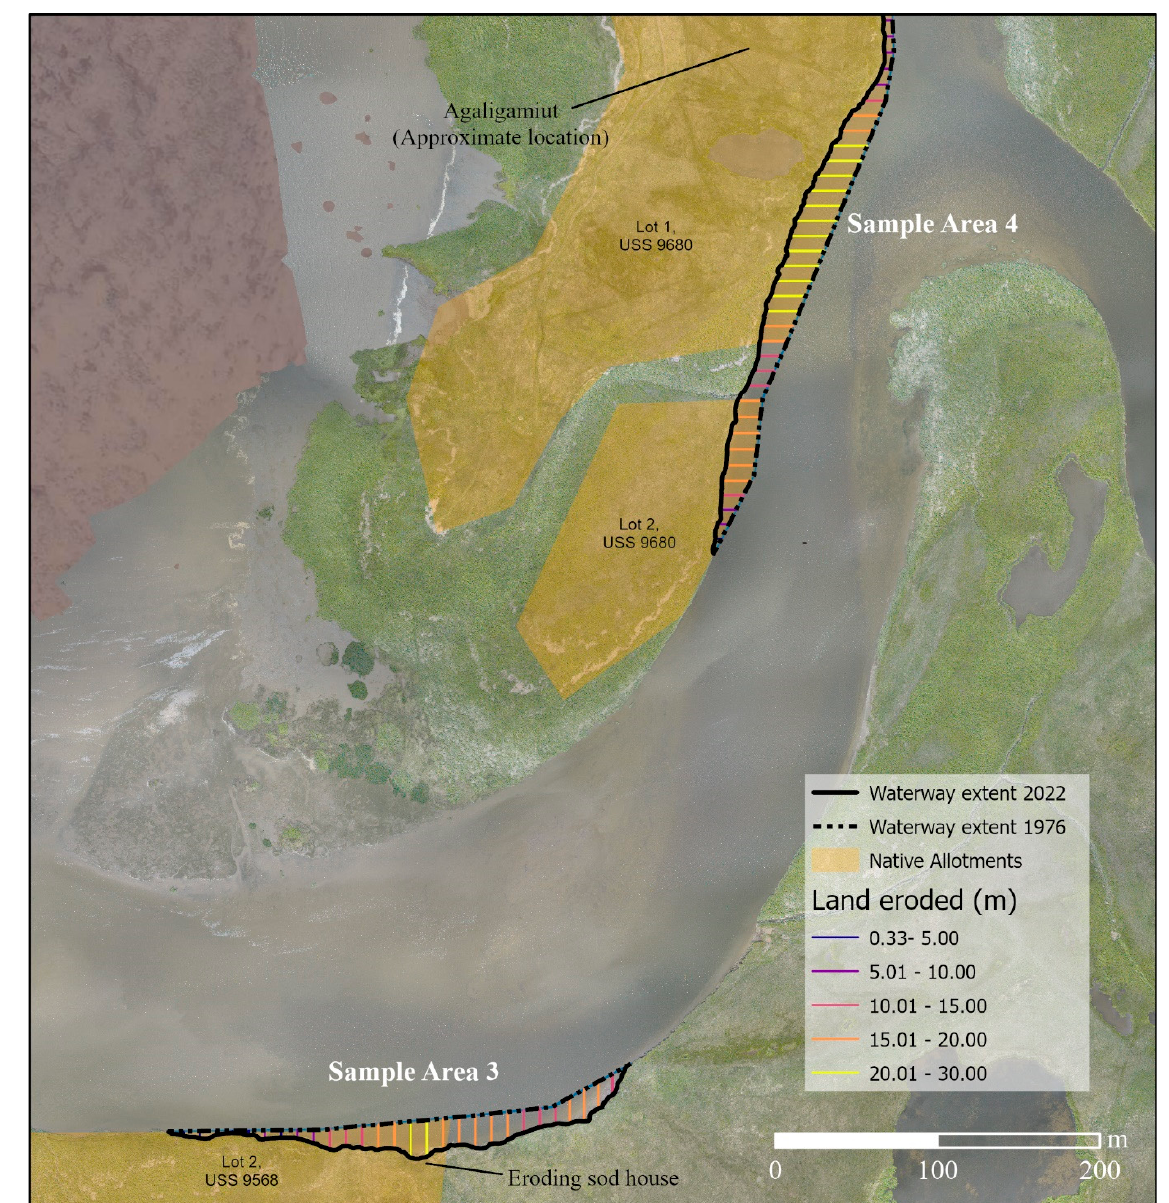
Figure 5. Erosion at the mouth of the Agalig. Aerial orthomosaic by authors (2022). The abandoned village near Sample area 4 was known as Agaligamiut. In the late 19th century, it was a larger settlement than Quinhagak, according to the US census. How-